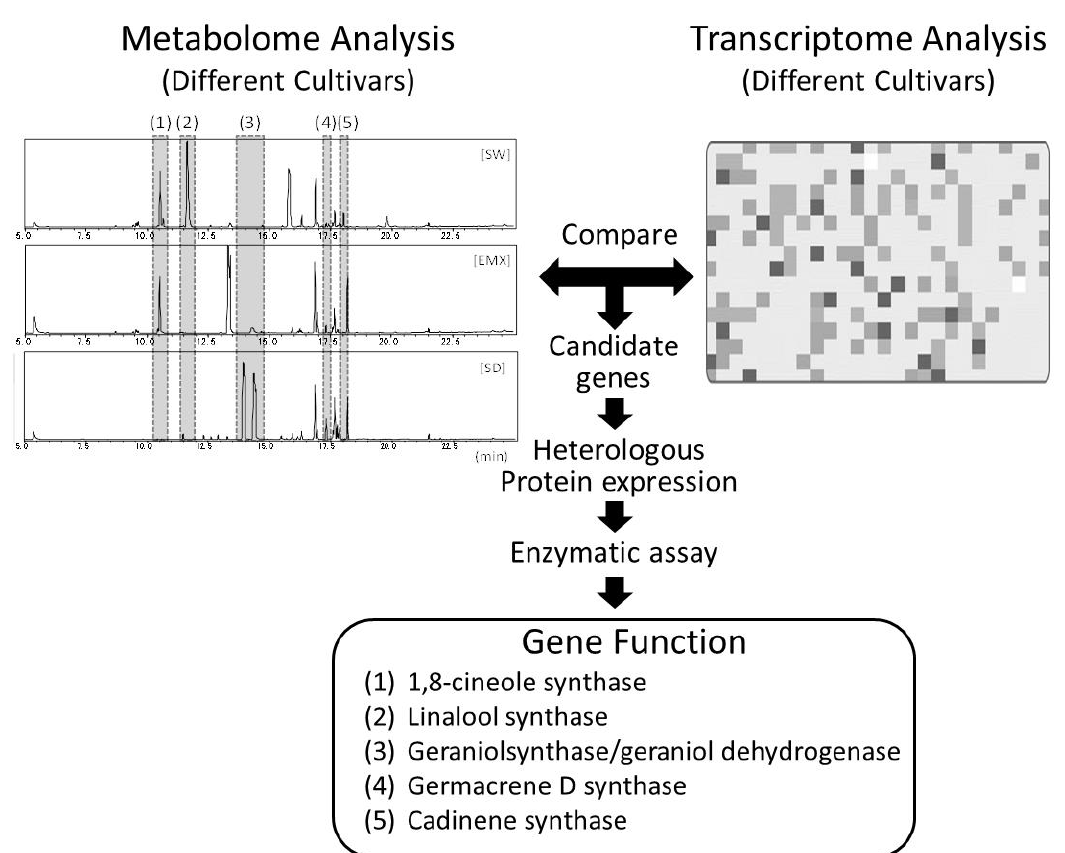
Figure 2. Metabolomics-driven screening of gene functions for synthesis of BVOCs. This is an example of finding of terpene synthase gene functions involved in aroma of Sweet basil ( Ocimum basilicum ) [50,84]. Integration of metabolome and transcriptome data facilitated the elucidation of gene